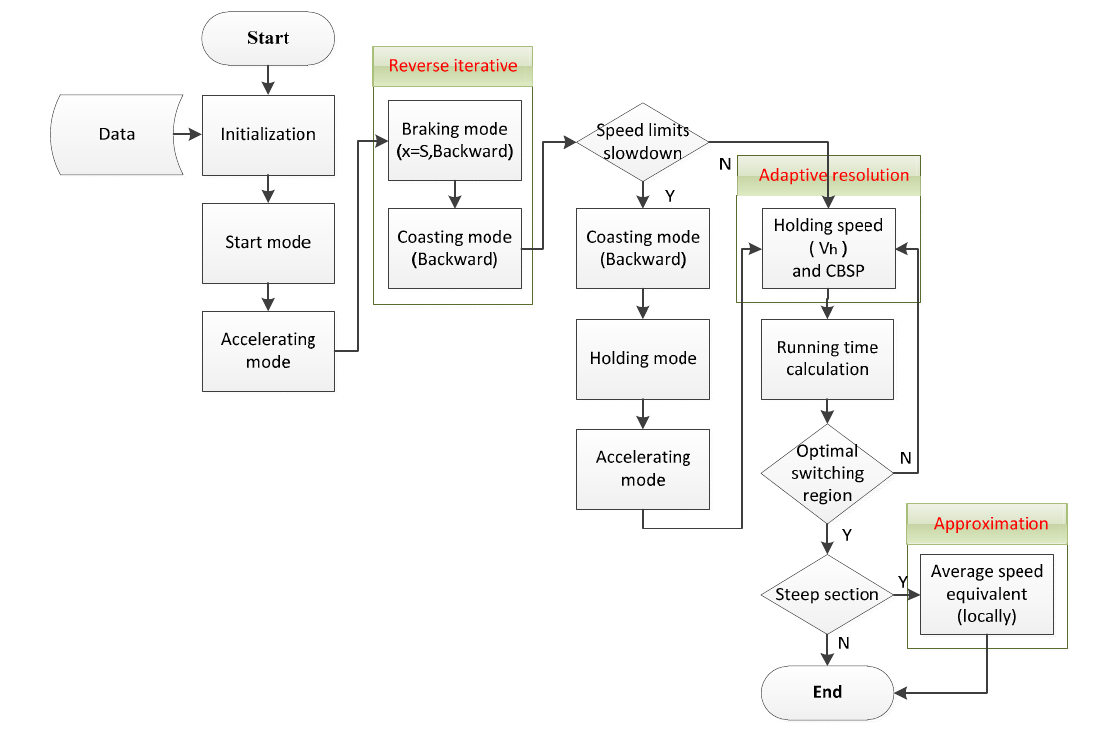
Figure 10. Simulation process of speed profile optimization.